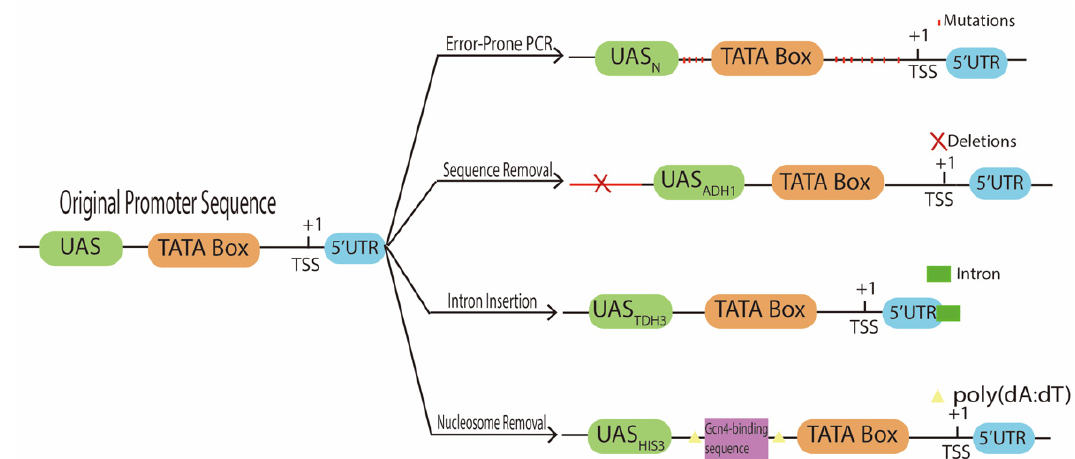
Figure 3. Synthetic promoters obtained by modifying the sequence of native promoters. Common methods to alter promoter sequence and activity are: point mutations via error-prone PCR [11], removal of functionless sequences [49,50], intron insertion along the 5 ′ UTR [51], and nucleosome removal [52].